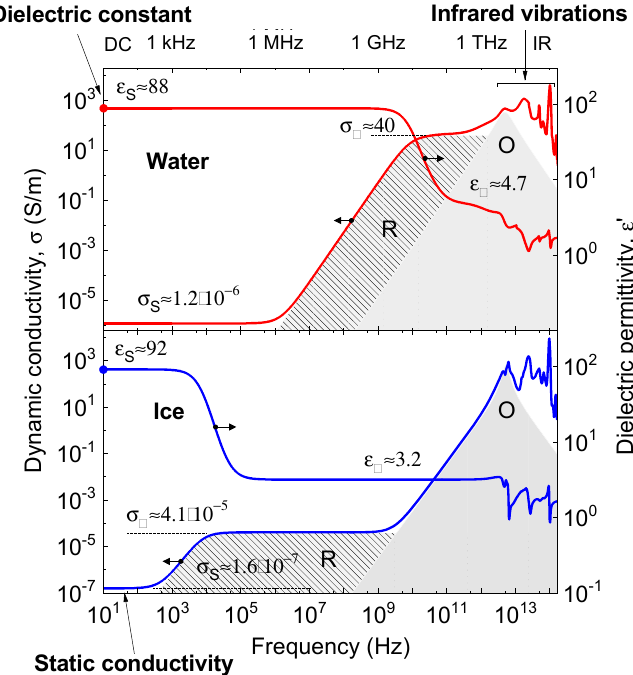
Figure 1. Broadband spectra of ice (blue) and water (red) in terms of dielectric permittivity ( ε′ ) and electrical conductivity ( σ